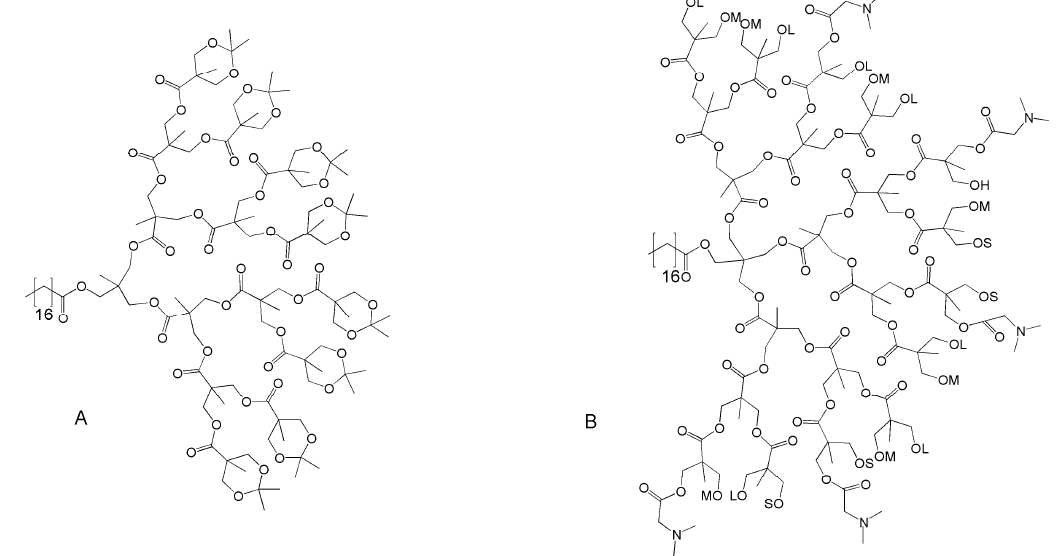
Figure 2. Polyester-based macromolecules reported by Alfei’s group: ( A ) [99]; in ( B ) (suffix M in the terminal moieties = L -arginine; L = L -lysine, S = sarcosine) [103].